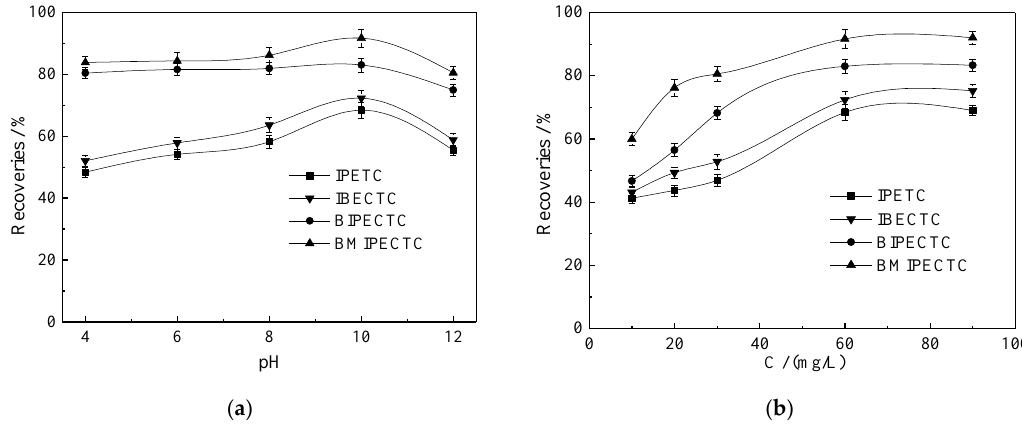
Figure 6. Effects of the pH and collector dosage on copper recoveries. ( a ) Slurry pH (collector dosage: 60 mg/L); ( b ) Collector dosage (pH = 10)